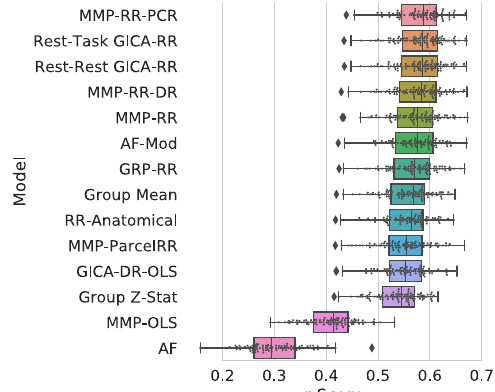
Figure 4. Pearson r correlation score results for 100 subject test set averaged across contrasts. Models are ordered top to bottom by score. These scores appear as the first column in Fig. 2. Top performing models perform similarly between each other. Individual subject scores from the test-set are plotted along with box- whisker plots showing quartiles of prediction score